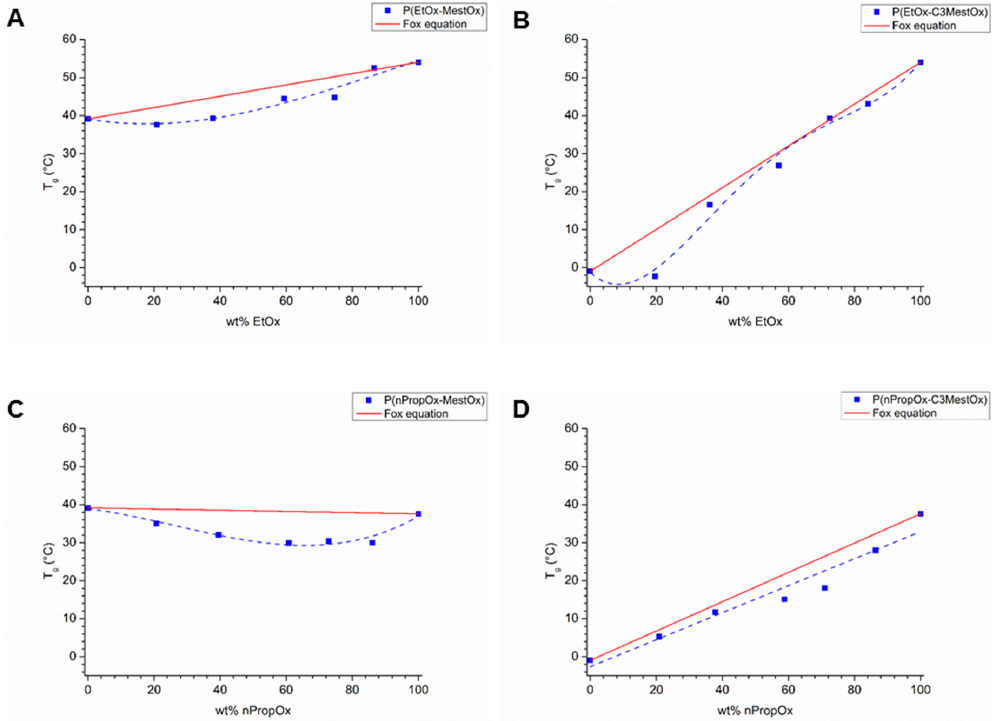
Figure 4. Glass transition temperatures as function of polymer composition of ( A ) P(EtOx–MestOx), ( B ) P(EtOx–C3MestOx), ( C ) P(nPropOx–MestOx), and ( D ) P(nPropOx–C3MestOx). Lines are added to guide the eye; the red line indicates the Fox equation.